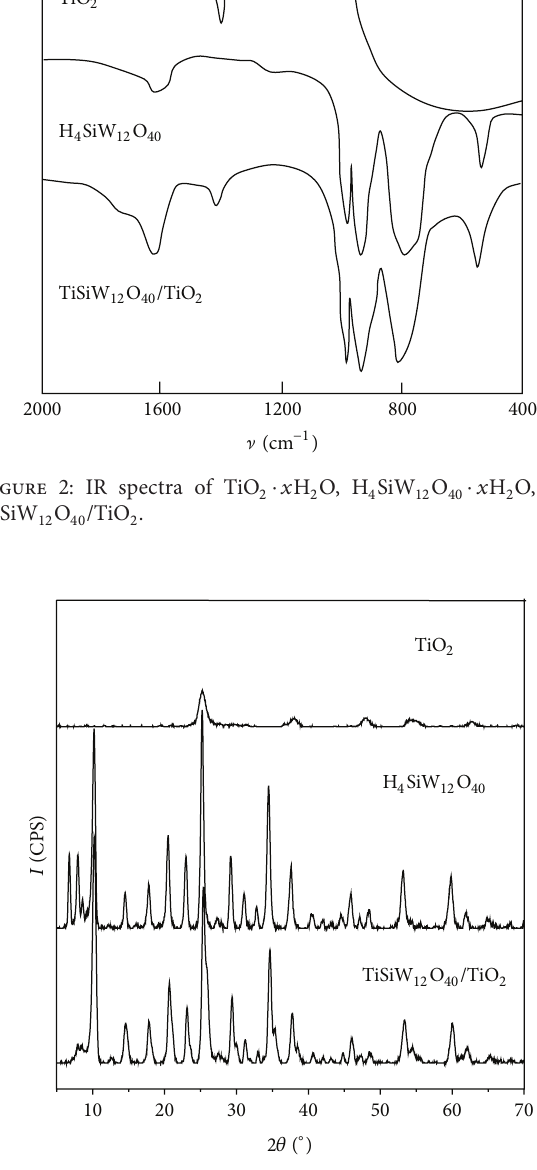
Figure 3: XRD spectra of TiO 2 , H 4 SiW 12 O 40 ⋅𝑥 H 2 O, and TiSiW 12 O 40 /TiO 2 .